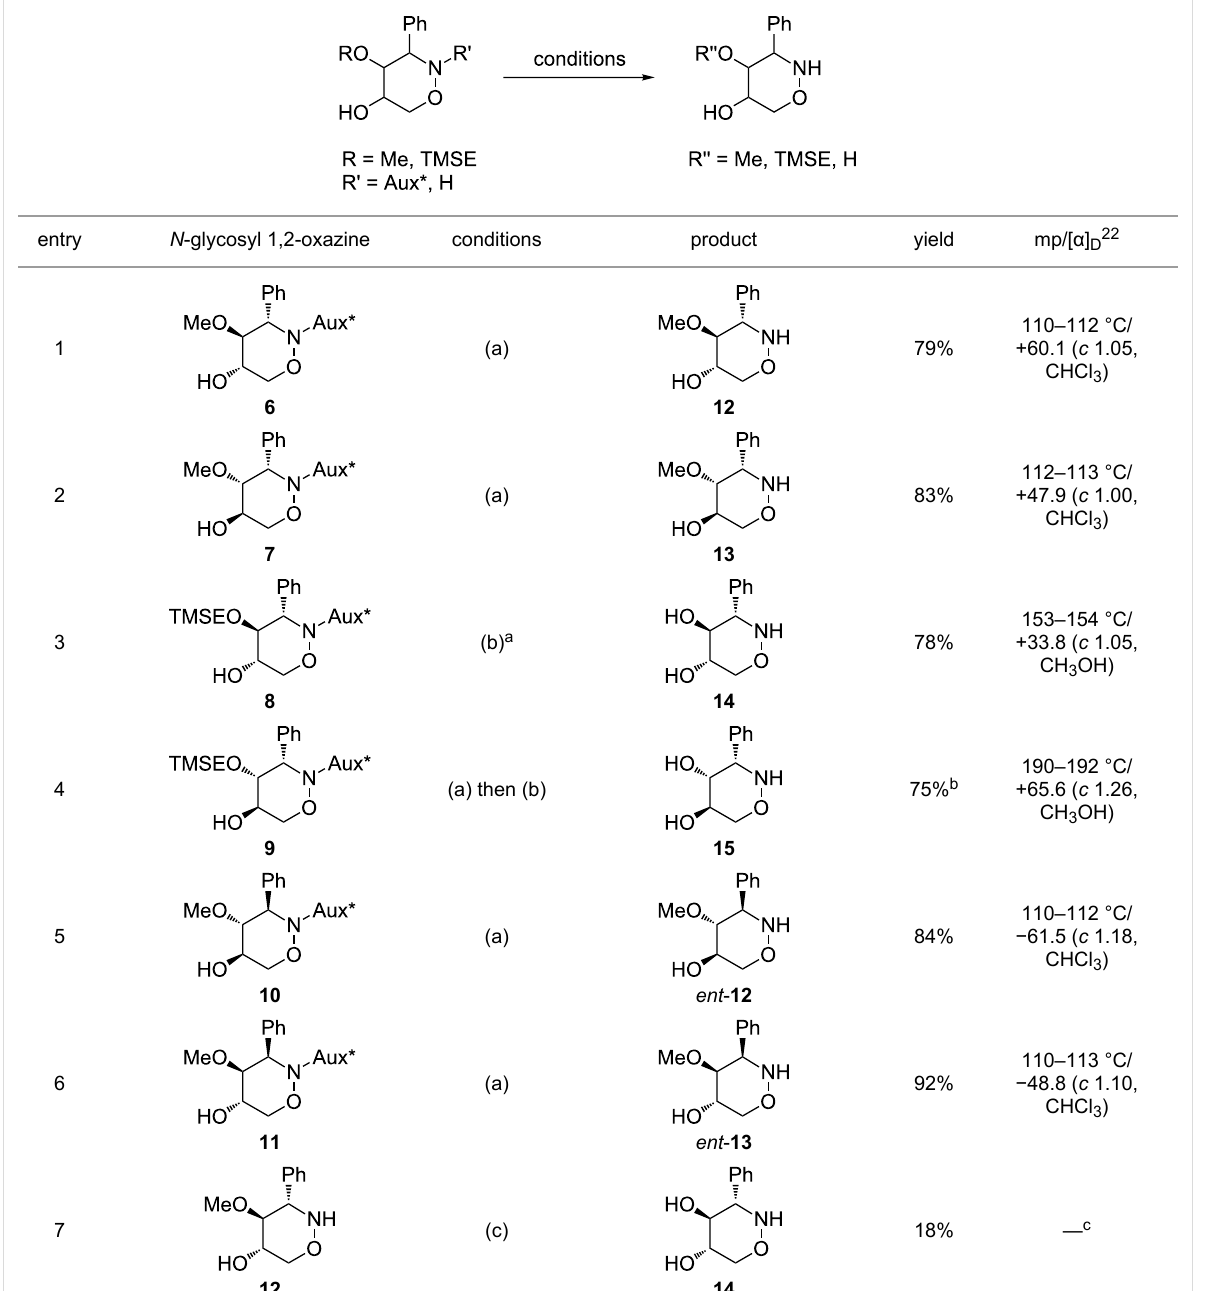
Table 2: Acid-induced cleavages of N - and O -protective groups of 5-hydroxy-1,2-oxazine derivatives 6 – 11 ; conditions: (a) HCl (1 M) in MeOH, 40 °C, 3.5 h; (b) DOWEX-50, EtOH, 50 °C, 4 d; (c) BBr 3 (3 equiv), CH 2 Cl 2 , − 78 °C (1 h) then rt, overnight.